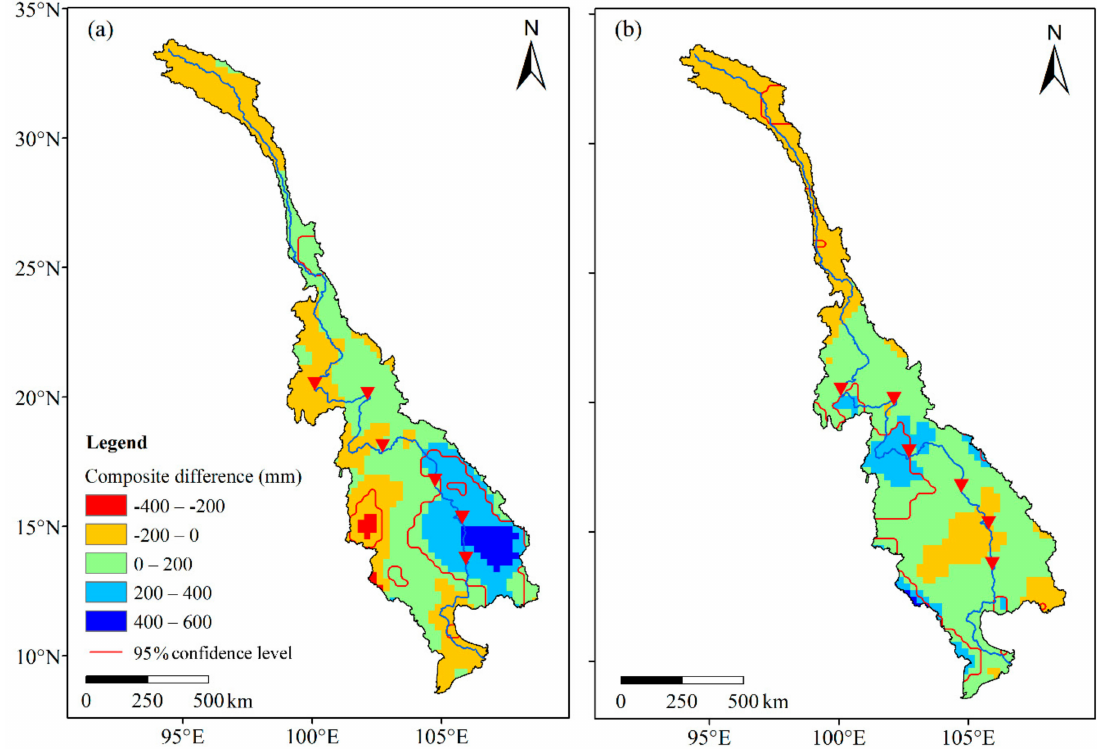
Figure 7. Composite di ff erence of precipitation during JJAS between strong and weak monsoon (( a ) western North Pacific summer monsoon (WNPSM) and ( b ) Indian summer monsoon (ISM)) years. In the regions enclosed by the red contour line, the composite di ff erences of precipitation during JJAS between strong and weak monsoon years are statistically significant at the 95% confidence